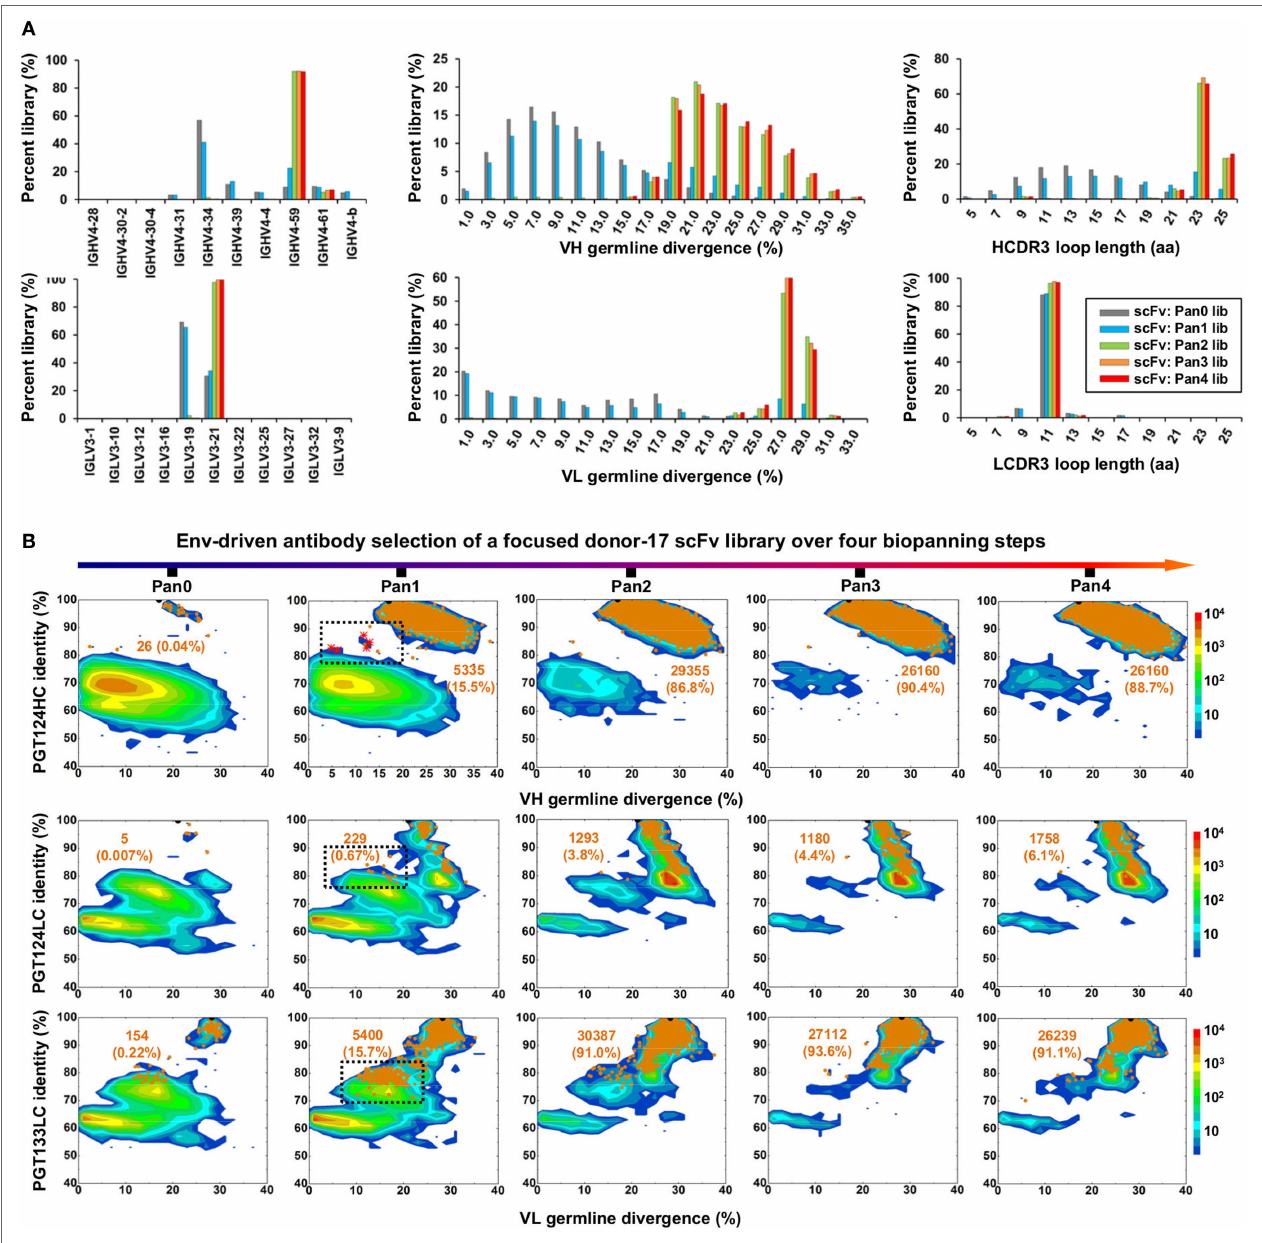
FigUre 5 | Digital panning of a focused donor-17 single-chain variable fragment (scFv) library against the native-like trimer. A focused scFv library was constructed from donor-17 peripheral blood mononuclear cells (PBMCs) using IgHV4- and IgLV3-specific primers. (a) Distributions of germline gene usage (left), somatic hypermutation (middle), and CDR3 loop length (right) are plotted for the five scFv libraries obtained from the trimer panning process. Histograms are color-coded following the same scheme as in Figure 2B . (B) Identity-divergence analysis of the five donor-17 scFv libraries obtained from the trimer panning process. For each library, sequences are plotted as a function of sequence identity to PGT124 HC (top), PGT124 LC (middle), and PGT133 LC (bottom), and sequence divergence from germline genes. Color-coding indicates sequence density at a particular point on the 2D plot. WT PGT124 and PGT133 are labeled on the 2D plots as black dots. Sequences with CDR3 identity of 95% or greater are shown as orange dots, with the number of sequences and library percentage labeled on the 2D plot for comparison. Sequences with low levels of SHM and moderate identity to the respective broadly neutralizing antibodies, corresponding to native intermediates (NINs), are circled by black dotted line boxes on the 2D plots for the Pan1 library. Five NIN-like scFv clones selected from the Pan1 library based on the HC identity to PGT124 are shown as red asterisks on the 2D